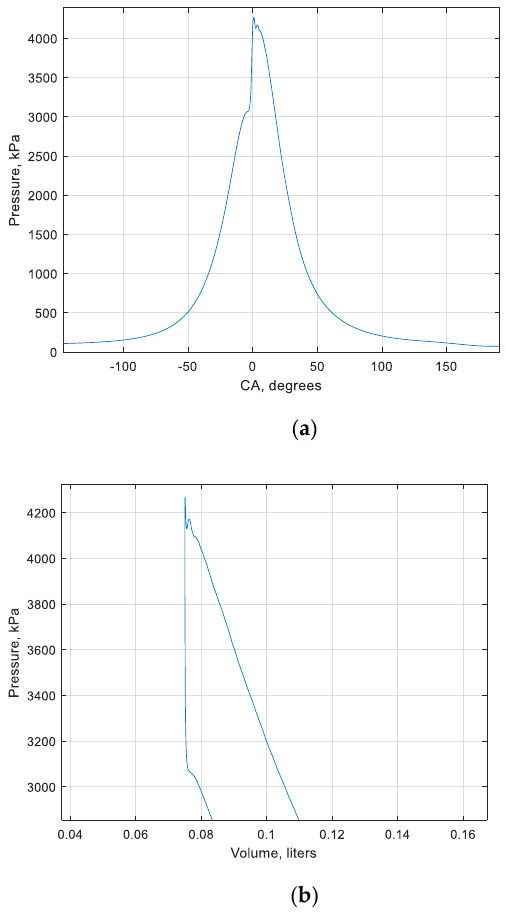
Figure 13. ( a ) Pressure vs. crank angle history on the RLE when the timing is retarded. Note that combustion is still fairly fast compared to BSL Case 3 (see Appendix A), but we can still consider this a close comparable case for PCP-PMP comparison. ( b ) Pressure vs. volume for the RLE in the retarded condition. Note that now the premixed combustion is right at the TDC with some significant heat release occurring past the TDC, which lowers PCP. This is to be contrasted against Figure 12b, where the premixed combustion is well before the TDC, and only a slight amount of heat is released before the TDC, or Figure 11 (red), where all the heat is released well before